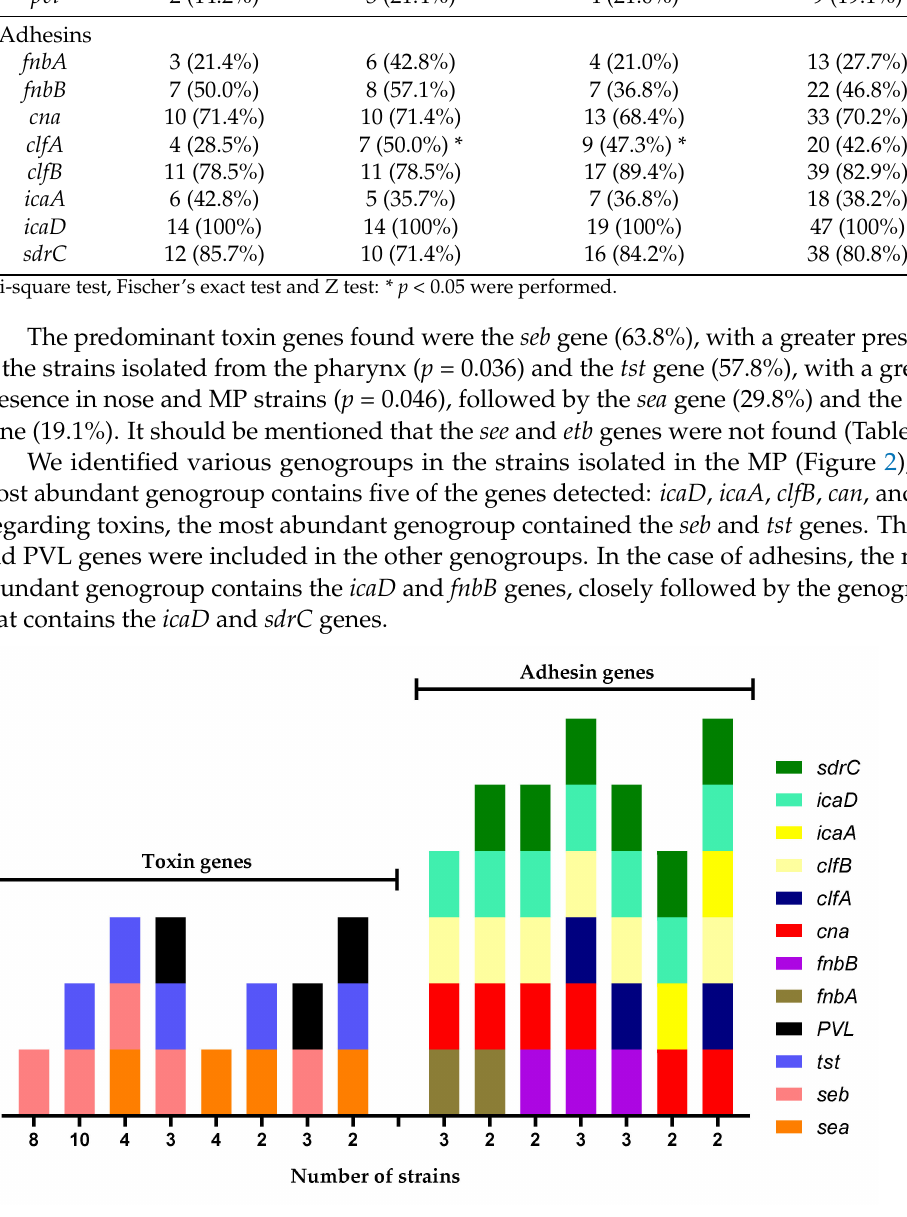
Figure 2. Genogroups of Staphylococcus aureus strains isolated from mobile